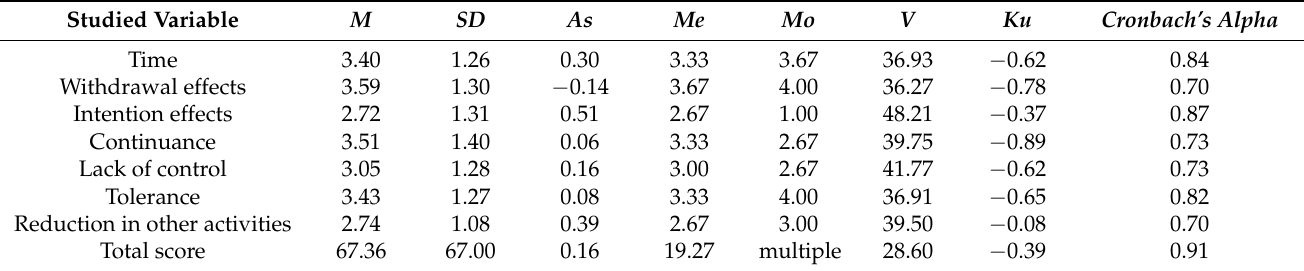
Table 2. Descriptive statistics and Cronbach’s alpha values for the entire sample.